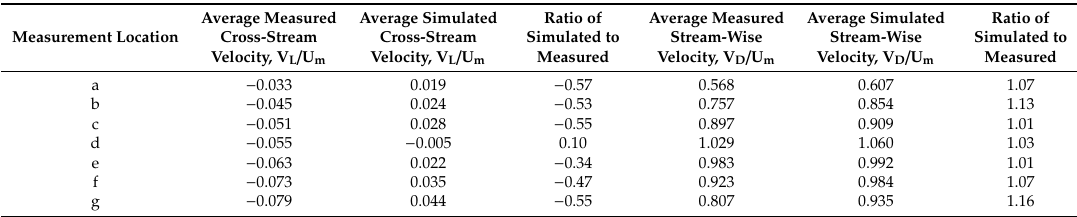
Table A7. Summary comparison of simulated and measured velocities at Cross-section 16 using the finest model mesh size (492 × 42 ×